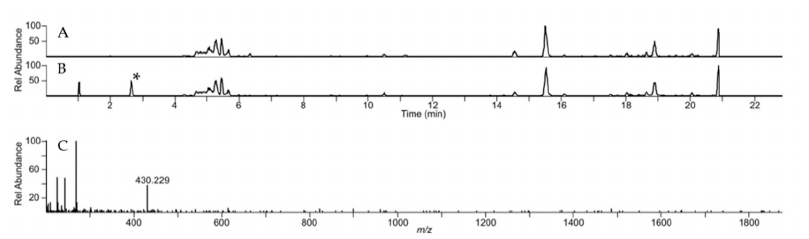
Figure 2. HPLC-MS analysis of bonsecamin production. A- and B-extracted ion chromatograms (430.5 ± 0.5 Da) of crude extracts of S. albus 2O18 and S. albus Del14, respectively. The new peak observed in the extract of S. albus 2O18 is marked with an asterisk (*). C–Mass spectrum of the new peak observed in the extract of S. albus 2O18.